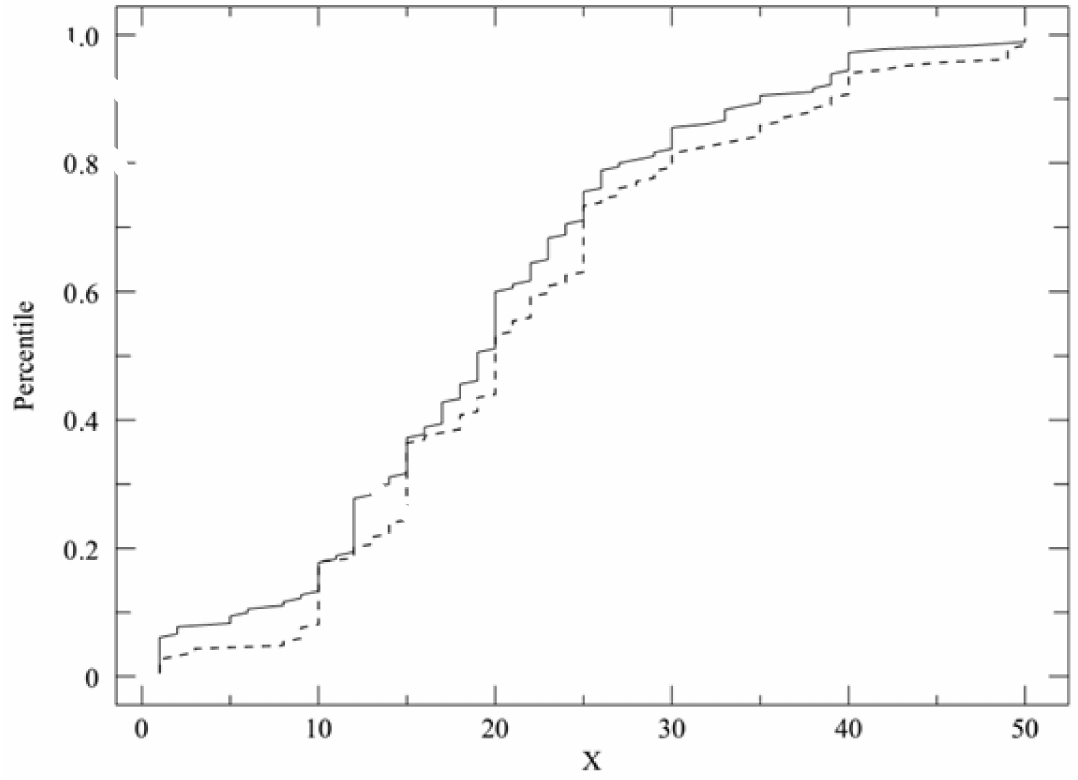
Figure 1. Distribution of numbers picked by For-voters (continuous line) and Against-voters